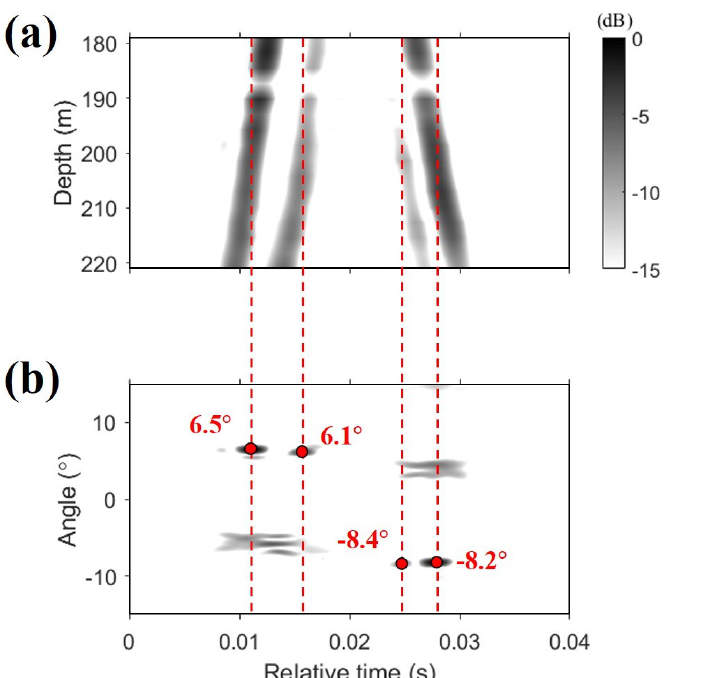
Figure 6. ( a ) Channel impulse response estimated at a range of 60 km from a linear frequency modu- lated (LFM) channel probe after matched-filtering. Four dominant paths are identified. ( b ) Beam-time migration of the channel impulse response corresponding to ( a ), respectively. The red dashed lines between the channel impulse response and the beam-time migration represent the relative time delays of the dominant paths, and the red circles on the beam-time migration plot represent the relative time delays and angles of the dominant